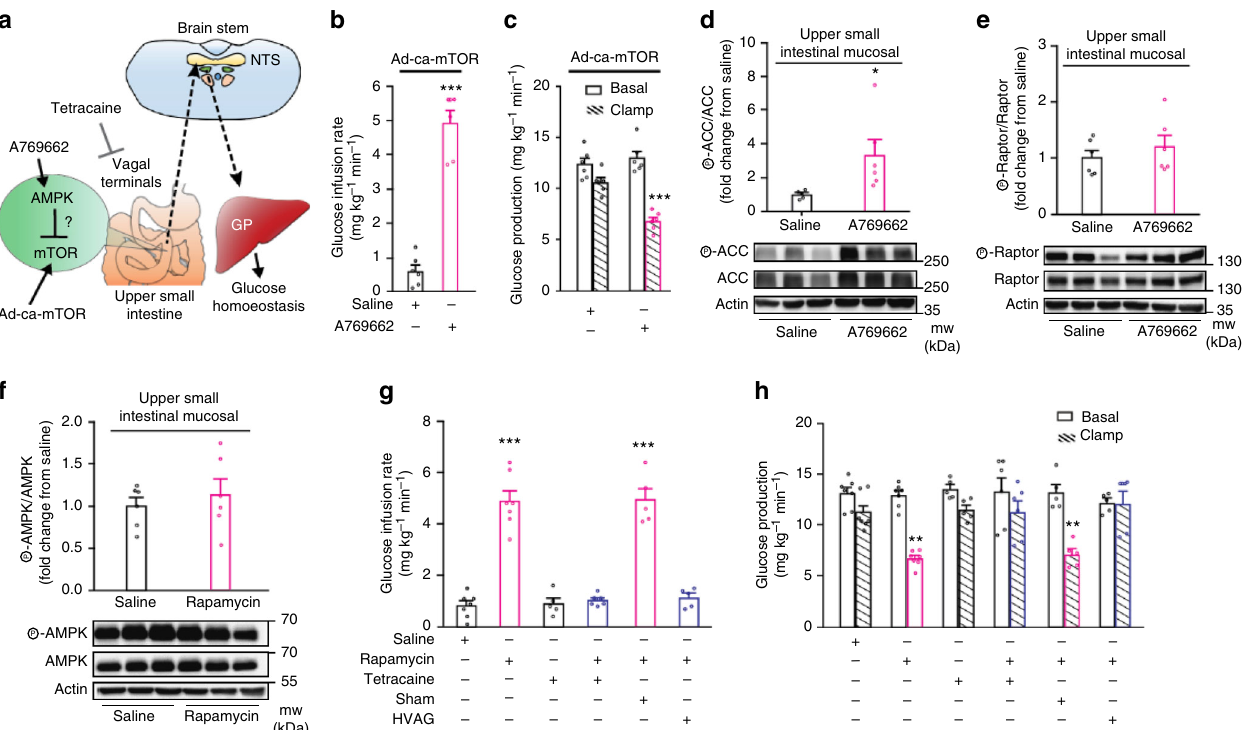
Fig. 4 Inhibition of upper small intestinal mTOR activates a gut – brain axis to lower hepatic glucose production. a Schematic representation of working hypothesis. b , c Glucose infusion rate ( b ) and glucose production ( c ) during the clamps in HFD rats infected with upper small intestinal Ad-ca-mTOR and infused with upper intestinal A769662 or saline. *** p < 0.001 vs. saline; determined by unpaired t -test ( n = 6 for each group). d , e Quantitative analysis and representative western blot of phosphorylated ACC ( d ) and raptor ( e ) protein expression in the upper intestinal mucosa of Ad-ca-mTOR infected HFD rats infused with upper intestinal saline or A769662. Actin, loading control. * p < 0.05 vs. saline as calculated by unpaired t -test ( n = 5 for saline, and 6 for A769662 in ACC, and 6/group in raptor). f Western blot of phosphorylated AMPK protein expression in the upper small intestinal mucosa of HFD rats infused with upper intestinal saline or rapamycin. Actin, loading control. * p < 0.05 vs. saline as calculated by unpaired t -test ( n = 6 for each group). g , h Glucose infusion rate ( g ) and glucose production ( h ) during clamps in HFD rats infused with upper small intestinal saline ( n = 7), rapamycin ( n = 7), tetracaine ( n = 5), rapamycin + tetracaine ( n = 6), rapamycin + sham ( n = 5) or hepatic vagal branch vagotomy (HVAG) ( n = 5). ** p < 0.01 or *** p < 0.001 vs. saline, tetracaine, tetracaine + rapamycin, and HVAG + rapamycin; determined by ANOVA with Tukey ’ s post hoc test. Values are shown as mean ±